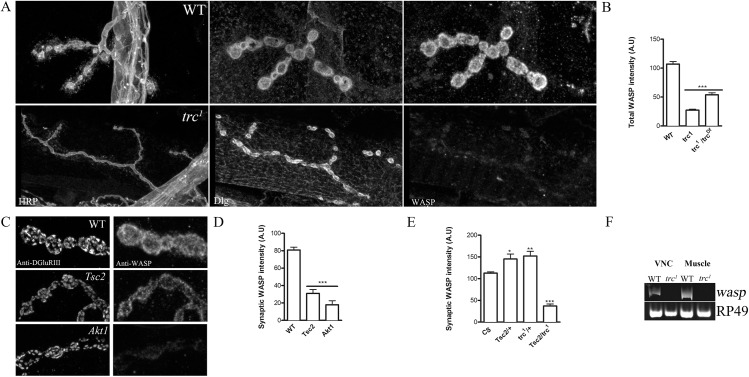
Synaptic WASP levels are reduced in trc and Tsc2 mutant synaptic boutons.
A. Representative confocal images of wild type (WT) and trc mutant synapses (trc
1) stained with anti-HRP, anti-Discs-large (Dlg) and anti-WASP antibodies. B. Quantification of total synaptic WASP levels in WT, trc
1 mutants and transheterozygote of trc
1 crossed to an independent deficiency line that deletes the entire trc gene (trc
1/trc
Df). C. Representative confocal images showing NMJ synapses of wild type (WT) and Tsc2 mutants and Akt1 mutants stained with antibodies against DGluRIII and WASP. D. Quantification of the synaptic WASP levels measured in genotypes described in C. E. Quantification of the synaptic WASP levels in WT (CS), heterozygotes of Tsc2 and trc
1 (Tsc2/+, trc1/+) and in their respective transheterozygotes (Tsc2/trc1). One-Way ANOVA followed by Tukey’s post-hoc test was performed. *p<0.01, **p<0.001, ***p<0.0001. Error bars represent S.E.M. F. Representative gel showing wasp transcripts from ventral nerve cords (VNC) and muscles of WT and trc
1 mutants. Ribosomal protein 49 (RP49) is used as a control.